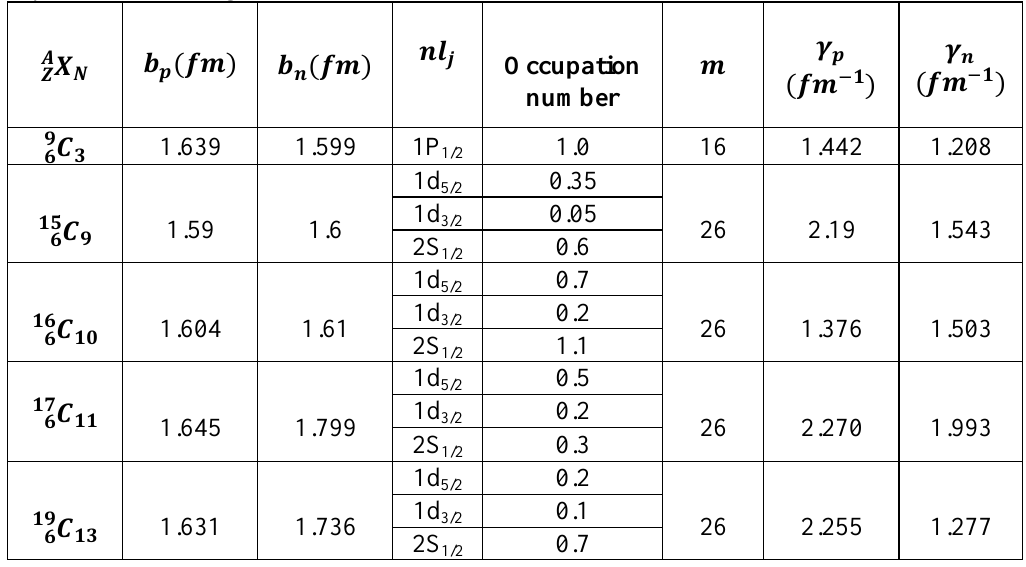
Table 3: The HO size parameters, occupation numbers and 16 C, 17 C and 19 C using HO+LST